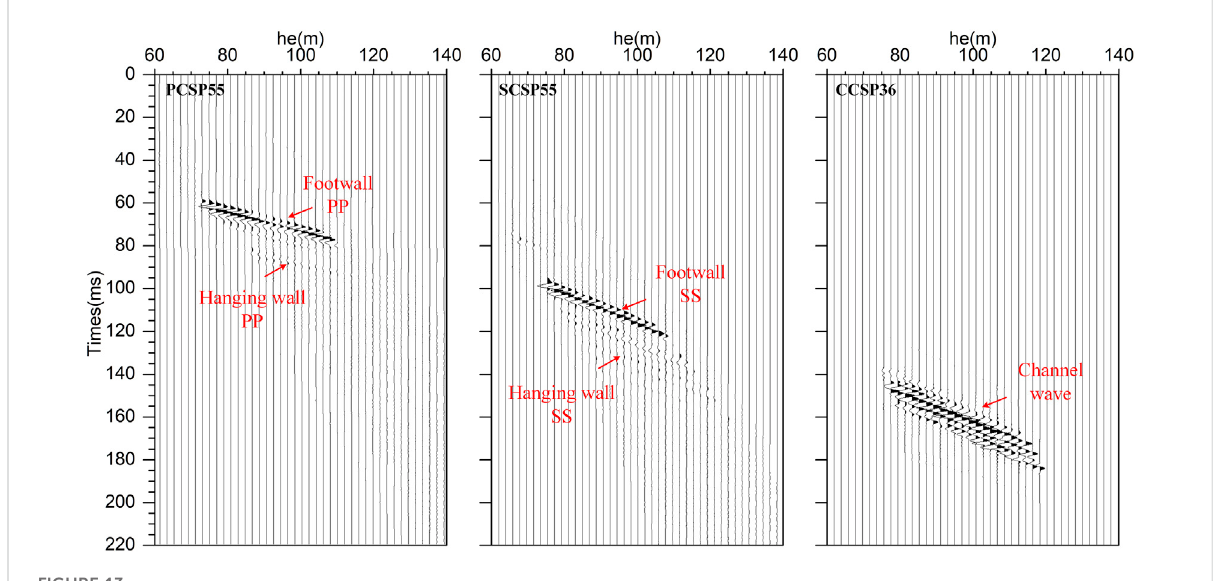
FIGURE 13 Multi-wave CSP gathers of the faulted coal seam